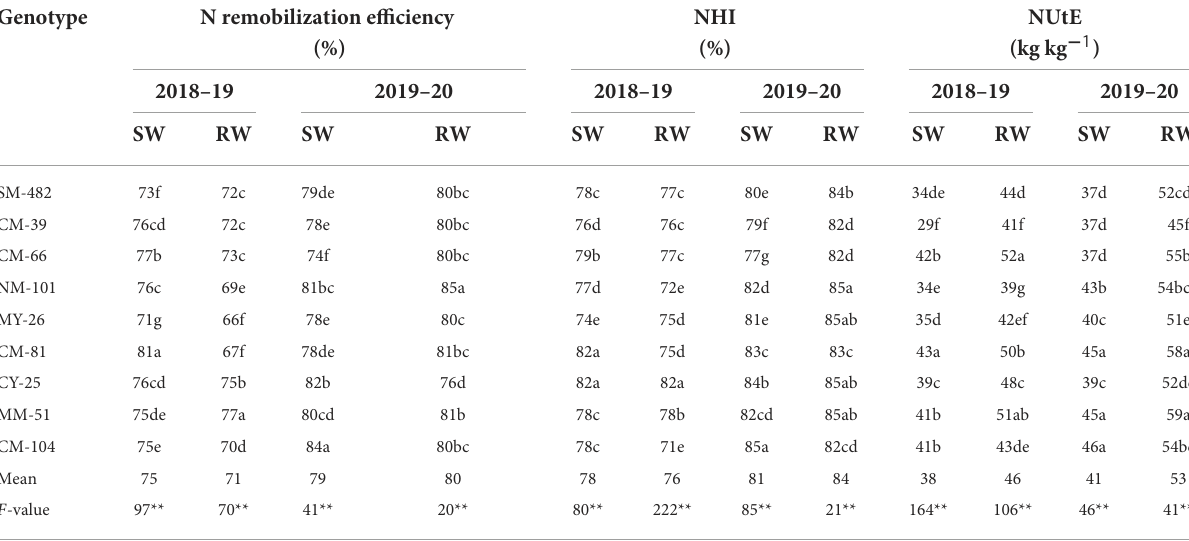
TABLE 6 The N utilization-related traits of nine wheat genotypes in two wheat cropping systems and two cropping years.